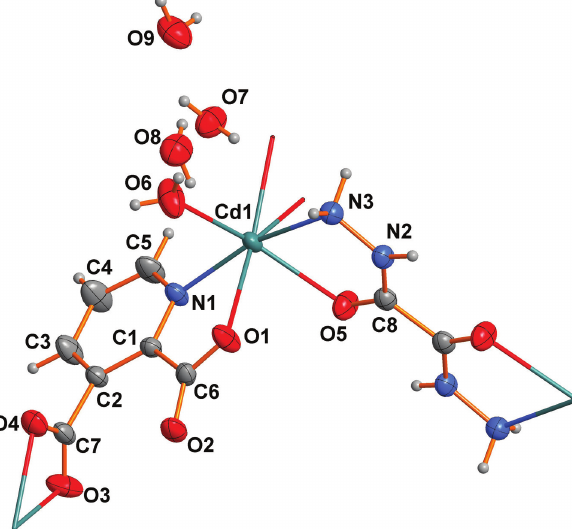
Table 1: Data collection and handling.